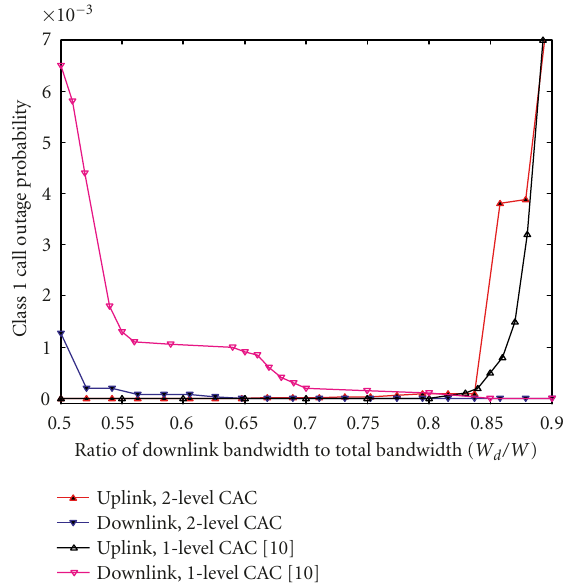
Figure 7: Outage probabilities versus downlink bandwidth ratio, W d /W.